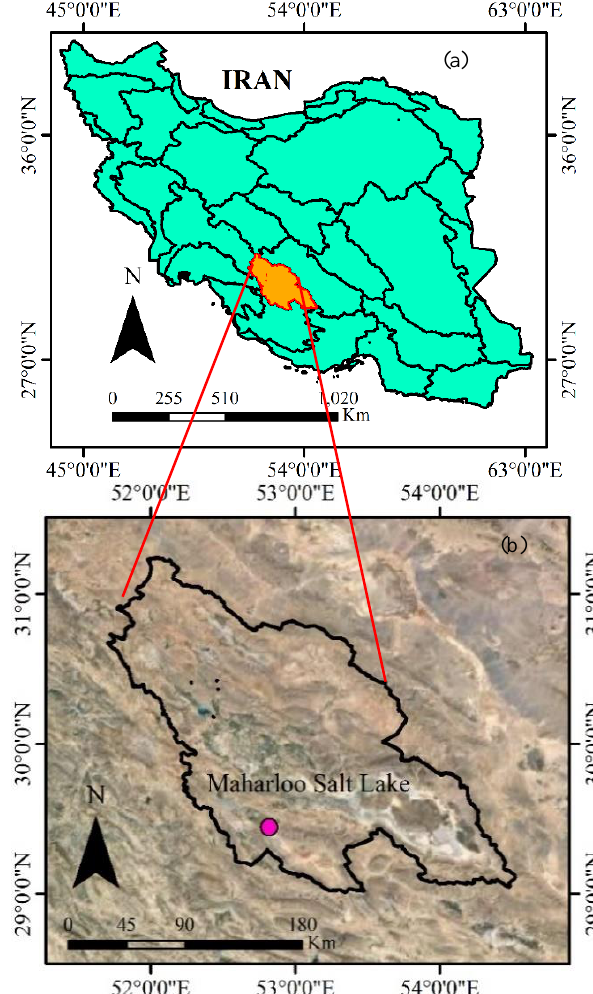
Figure 1 . Location of a) Tasht-Bakhtegan-Maharloo Basin in southwest Iran, and b) Maharloo Salt Lake in its hydrologic